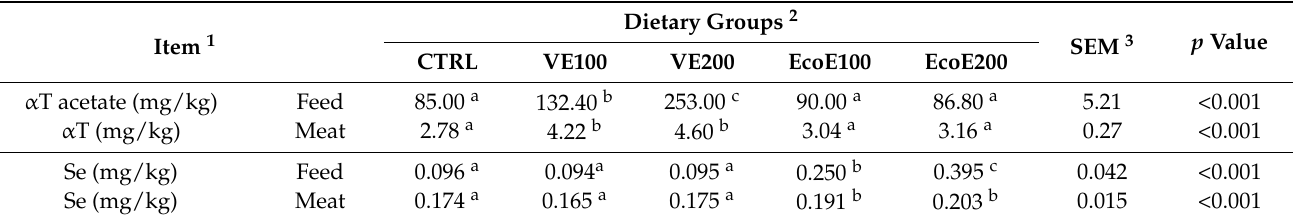
Table 2. The contents of α -tocopheryl acetate and selenium in feed and α -tocopherol and selenium in minced meat (Data from Minardi et al.